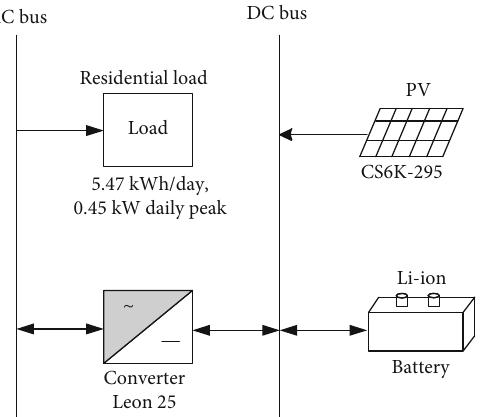
Figure 6: Layout diagram for o ff -grid power system with PV, battery and